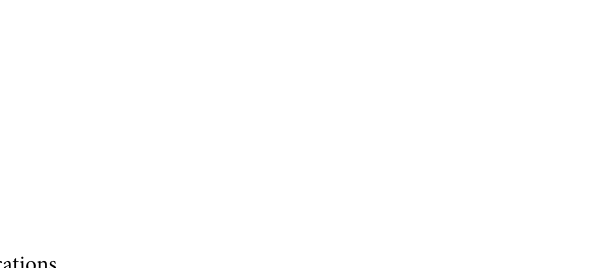
Table 1. Omnibot main technical specifications.